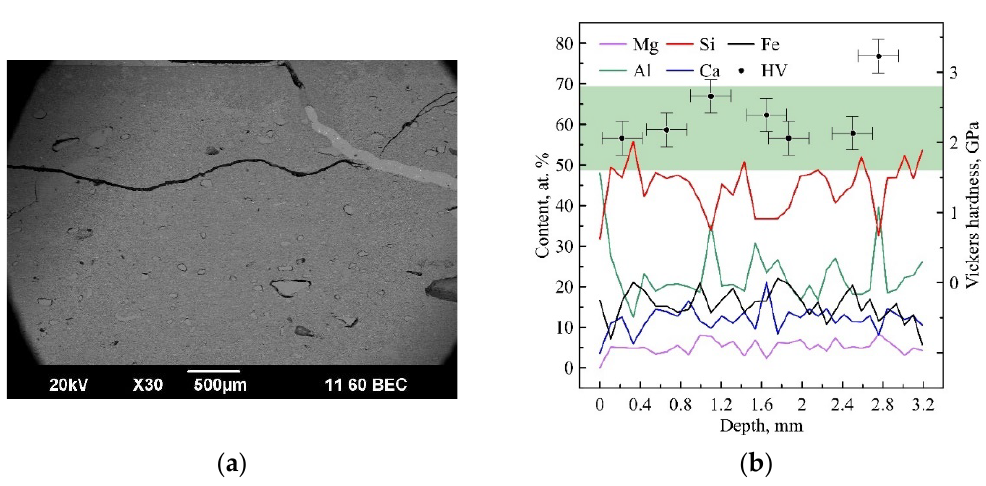
Figure 3. SEM image ( a ) Al-zone distribution, ( b ) distribution of elements on sample.